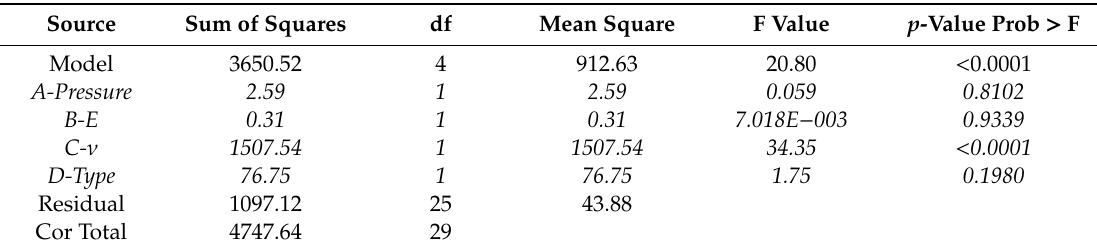
Table 6. ANOVA on the values of the transversal dimension of the tyre footprint referred to the four possible factors of